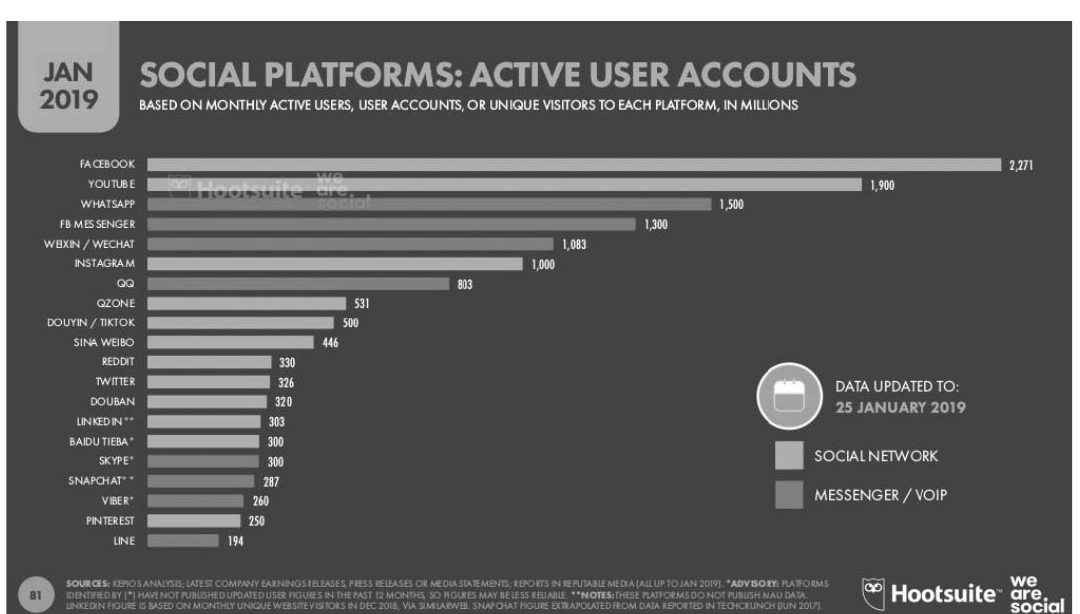
Figure 9. (cid:3)(cid:180)(cid:39)(cid:76)(cid:74)(cid:76)(cid:87)(cid:68)(cid:79)(cid:3)(cid:21)(cid:19)(cid:20)(cid:28)(cid:181)(cid:3)(cid:85)(cid:72)(cid:83)(cid:82)(cid:85)(cid:87)(cid:17)(cid:3)(cid:55)(cid:82)(cid:87)(cid:68)(cid:79)(cid:3)(cid:80)(cid:72)(cid:80)(cid:69)(cid:72)(cid:85)(cid:86)(cid:3)(cid:83)(cid:82)(cid:85)(cid:87)(cid:68)(cid:79)(cid:86)(cid:3)(cid:86)(cid:82)(cid:70)(cid:76)(cid:68)(cid:79)(cid:3)(cid:81)(cid:72)(cid:87)(cid:90)(cid:82)(cid:85)(cid:78)(cid:86)(cid:3)(cid:76)(cid:81)(cid:3)(cid:82)(cid:85)(cid:71)(cid:72)(cid:85)(cid:3) (cid:73)(cid:85)(cid:82)(cid:80)(cid:3)(cid:79)(cid:68)(cid:85)(cid:74)(cid:72)(cid:86)(cid:87)(cid:3)(cid:87)(cid:82)(cid:3)(cid:86)(cid:80)(cid:68)(cid:79)(cid:79)(cid:72)(cid:86)(cid:87) (cid:54)(cid:82)(cid:88)(cid:85)(cid:70)(cid:72)(cid:29) (cid:75)(cid:87)(cid:87)(cid:83)(cid:86)(cid:29)(cid:18)(cid:18)(cid:86)(cid:82)(cid:70)(cid:76)(cid:68)(cid:79)(cid:83)(cid:85)(cid:72)(cid:86)(cid:86)(cid:17)(cid:83)(cid:79)(cid:18)(cid:21)(cid:19)(cid:20)(cid:28)(cid:18)(cid:19)(cid:21)(cid:18)(cid:76)(cid:79)(cid:88)(cid:16)(cid:88)(cid:93)(cid:92)(cid:93)(cid:92)(cid:81)(cid:76)(cid:78)(cid:81)(cid:76)(cid:78)(cid:16)(cid:92)(cid:86)(cid:93)(cid:81)(cid:72)(cid:16)(cid:93)(cid:16)(cid:86)(cid:76)(cid:72)(cid:70)(cid:76)(cid:16)(cid:76)(cid:16)(cid:86)(cid:82)(cid:70)(cid:76)(cid:68)(cid:79)(cid:16)(cid:80)(cid:72)(cid:71)(cid:76)(cid:68)(cid:16)(cid:90)(cid:16)(cid:21)(cid:19)(cid:20)(cid:28)(cid:16)(cid:85)(cid:82)(cid:78)(cid:88)